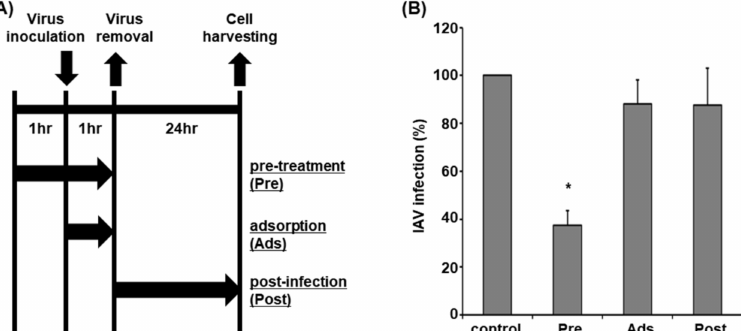
Figure 1. Virucidal activity of APE against IAV. The 70% ethanol extract of A. pseudoglehnii was used to treat IAV at a concentration of 10 µ g/mL using three protocols. ( A ) Schematic representation of the time-of-drug-addition assay. ( B ) After treatments, viral RNA transcript levels were determined via qRT-PCR using primers specific for IAV M1 and GAPDH. Experiments were performed in triplicate and data expressed as GAPDH-normalized values relative to control. The viral RNA transcript level in DMSO-treated cells was set as 100%. * p < 0.05 (Student’s t -test). Pre, pre-treatment; Ads, Adsorption; Post, post-treatment.